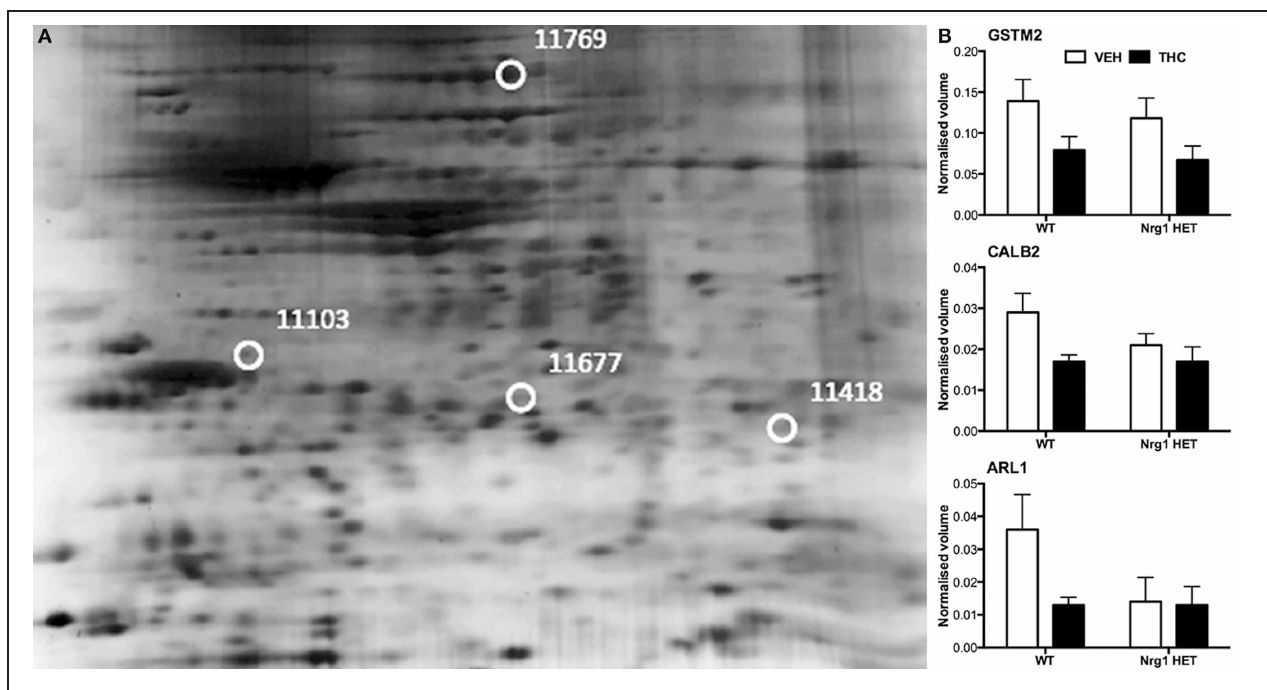
FIGURE 2 | Adolescent hippocampal proteomics comparing adolescent WT mice treated with vehicle and THC. (A) Representative 2DE gel images showing positions of significantly altered protein spots, the horizontal axis split by isoelectric point,